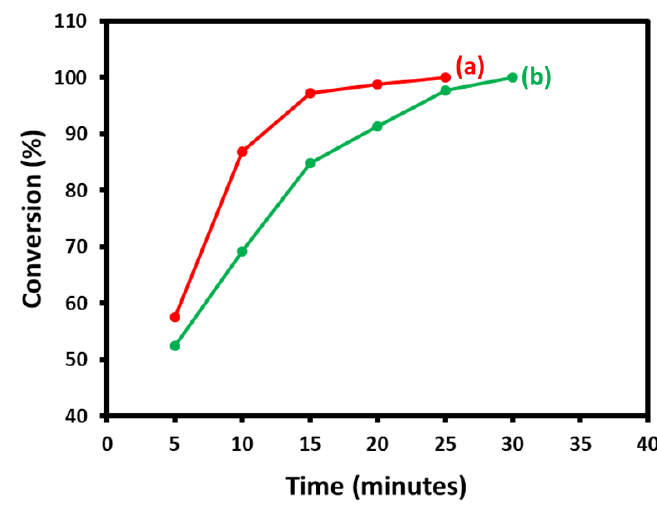
Figure 13. Comparison study of time-dependent conversion efficiency of the Suzuki reaction